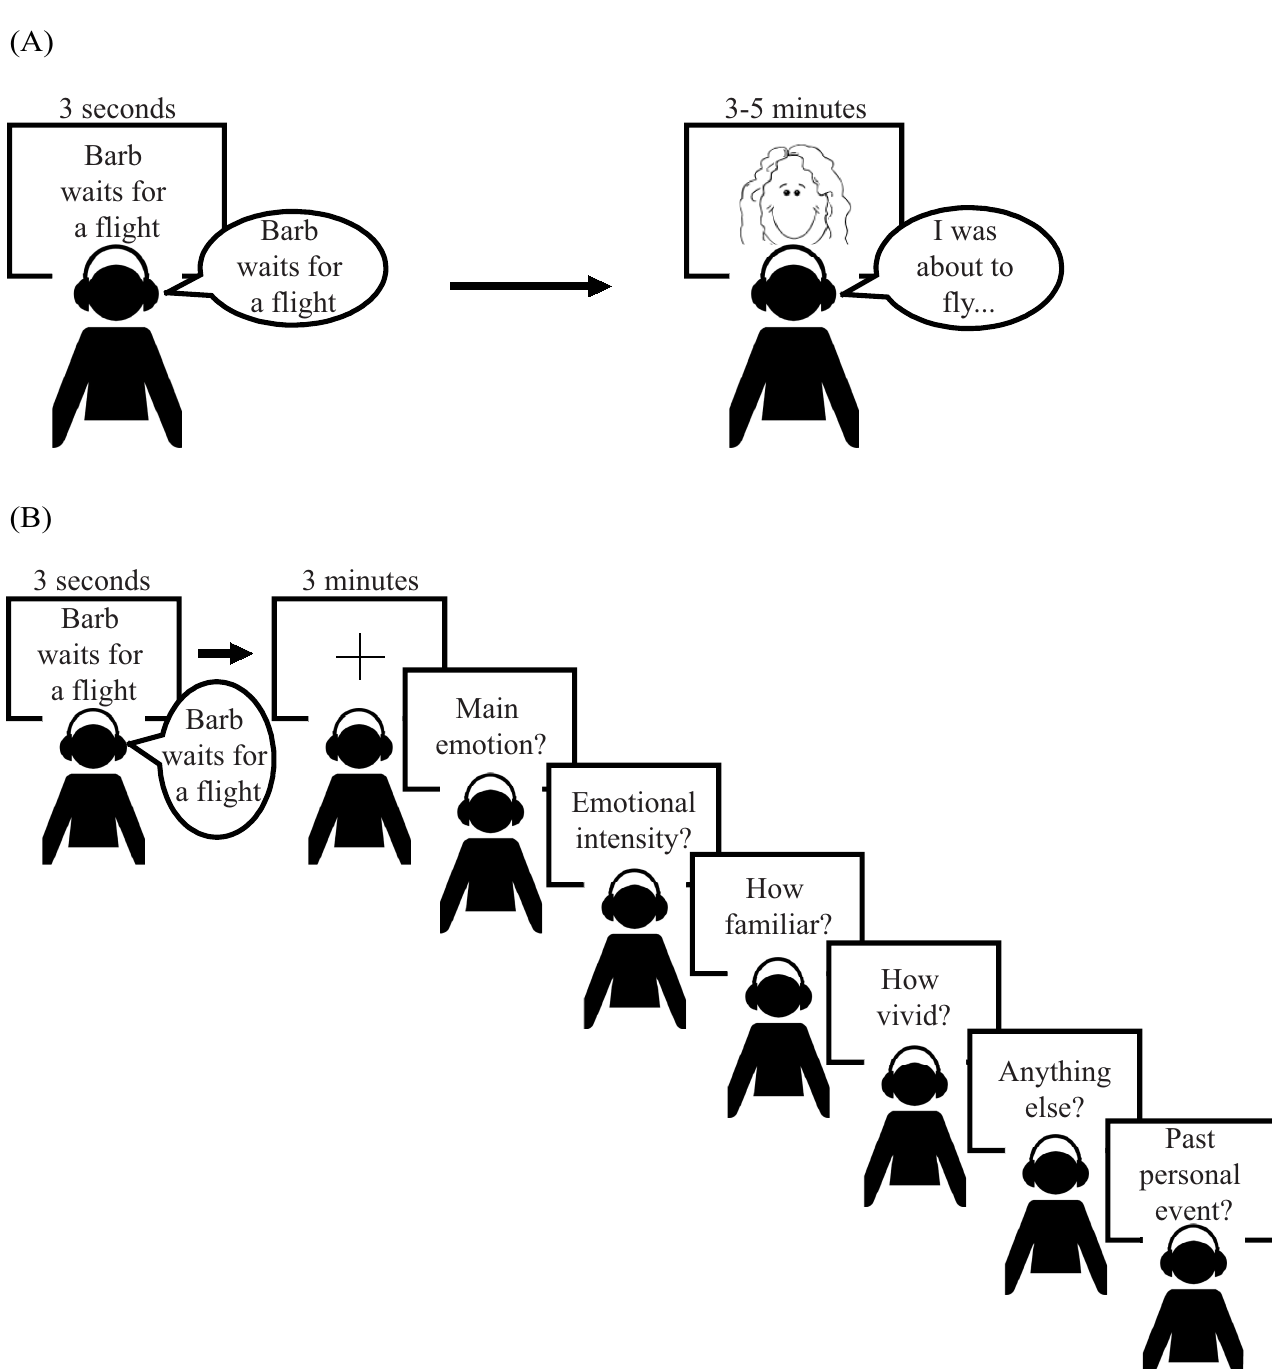
Fig 1. Visual depiction of procedure in Study 1. (A) Study phase procedure: Participants were presented with the narrative title visually for 3 seconds while also hearing the narrative title spoken by the actress. Participants then watched and listened to the corresponding video which lasted between 3–5 minutes. (B) Test phase procedure: Participants were presented with the same audiovisual title as in the study phase and were then given 3 minutes to verbally recall as much as possible from the corresponding narrative. Follow free recall, participants were asked to indicate the narrative’s main emotion, emotional intensity, familiarity, vividness, if there was anything else they could recall, and whether the narrative reminded them of a past personal